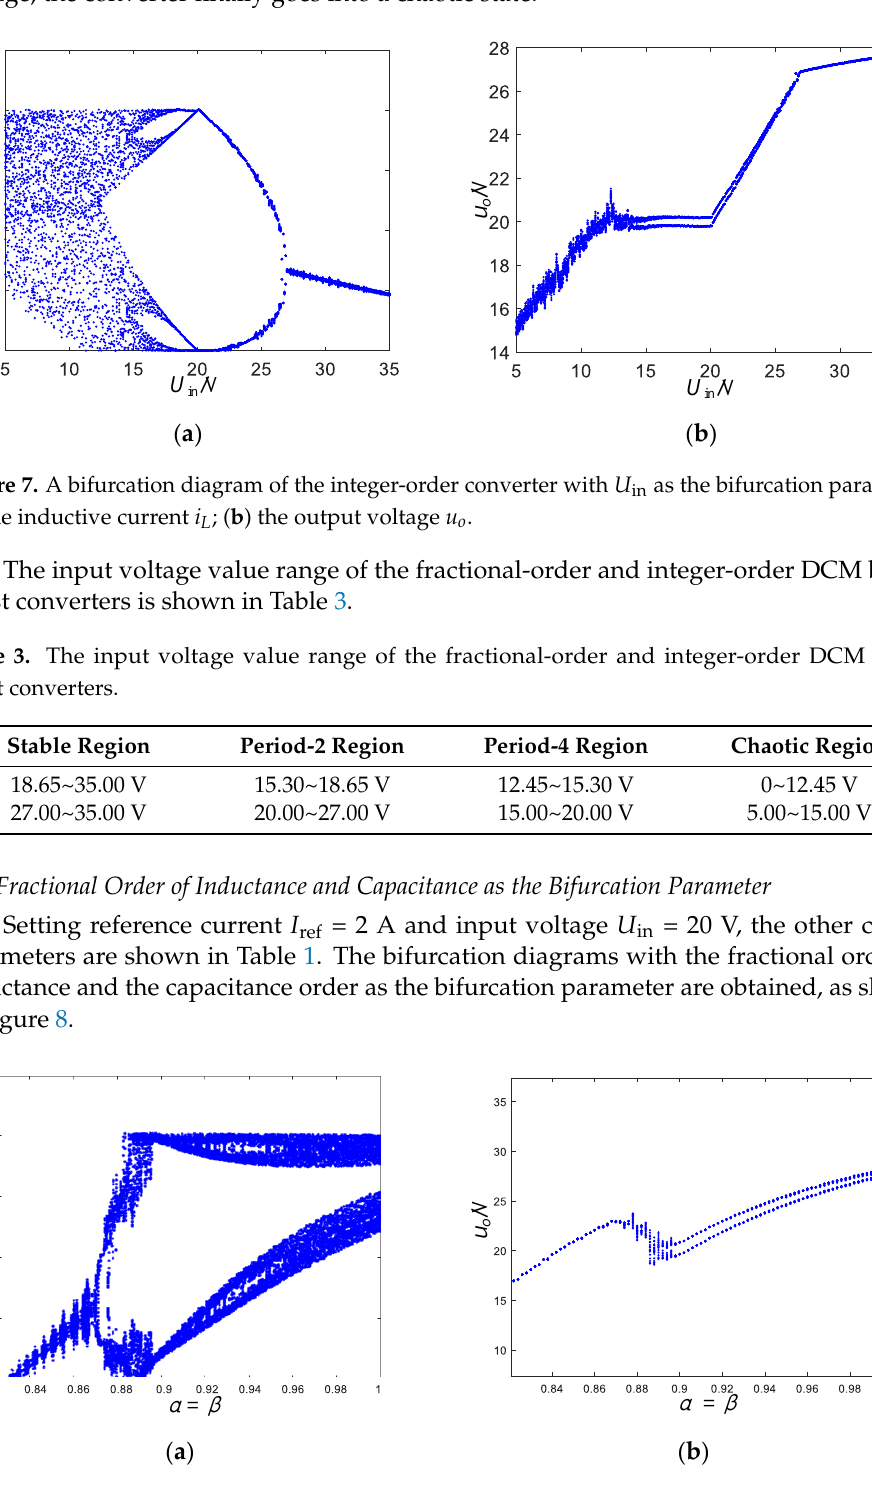
Figure 8. A bifurcation diagram with the inductance and capacitance order as the bifurcation parameter: ( a ) the inductive current i L ; ( b ) the output voltage u o . As is shown in Figure 8, when fractional-order α = β < 0.868, the converter works in stable period-1 state. When α = β = 0.868, a period-doubling bifurcation takes place, and the converter goes into the period-2 state. The converter can go to the chaos region at α = β = 0.92. When α = β = 1, the converter has entered a chaotic state and the system is